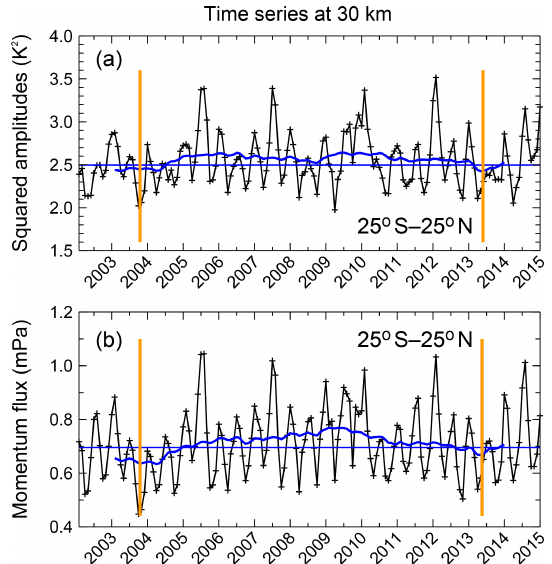
Figure 10. Time series of GW squared amplitudes (a) and absolute momentum flux (b) at 30km. Values are averaged over the latitude band 25 ◦ S–25 ◦ N. Blue curves represent 25-month running means. Horizontal blue lines are the median values of the respective time series. Orange vertical lines mark the two minima of a potentially decadal